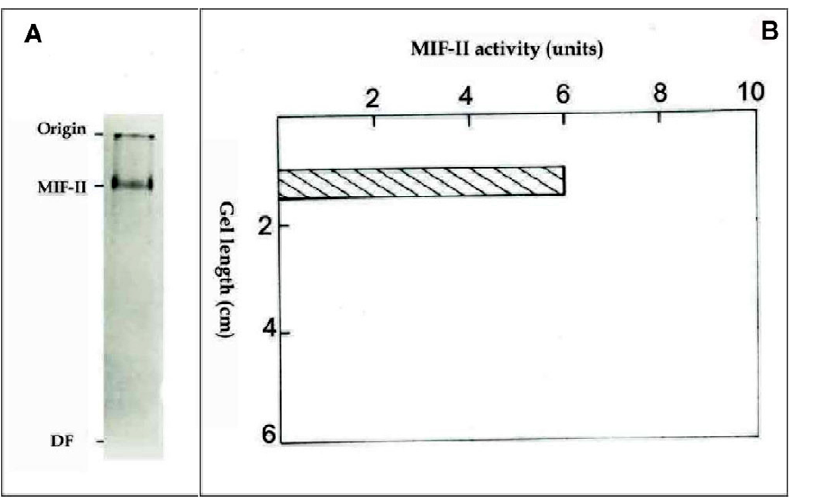
Figure 1. Non-denaturing polyacrylamide gel electrophoresis of the purified MIF-II on 5% gel. Staining of gel and MIF-II activity elution from gel were carried out as described in ‘‘Materials & Methods’’ section. A) 15 m g of purified MIF-II. B) MIF-II activity measured from the gel slices. doi:10.1371/journal.pone.0012039.g001 PLoS ONE |